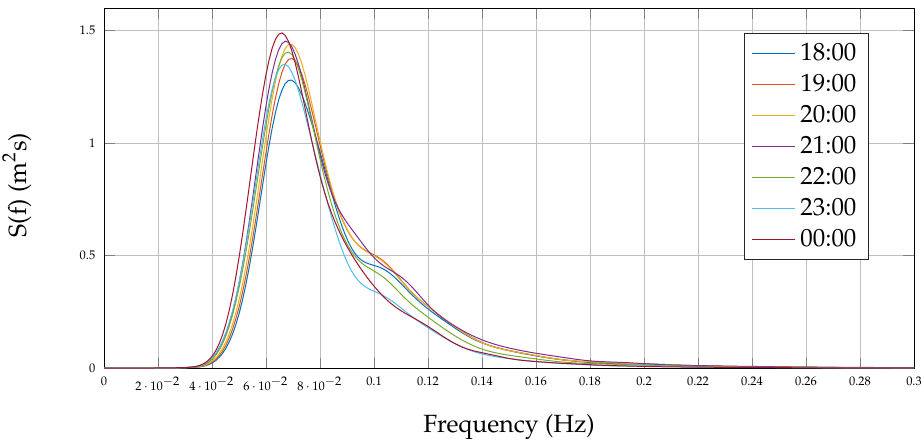
Figure 9. Spectral output from WAVEWATCH III model used to derive a 60 min wave train to force NEWRANS.